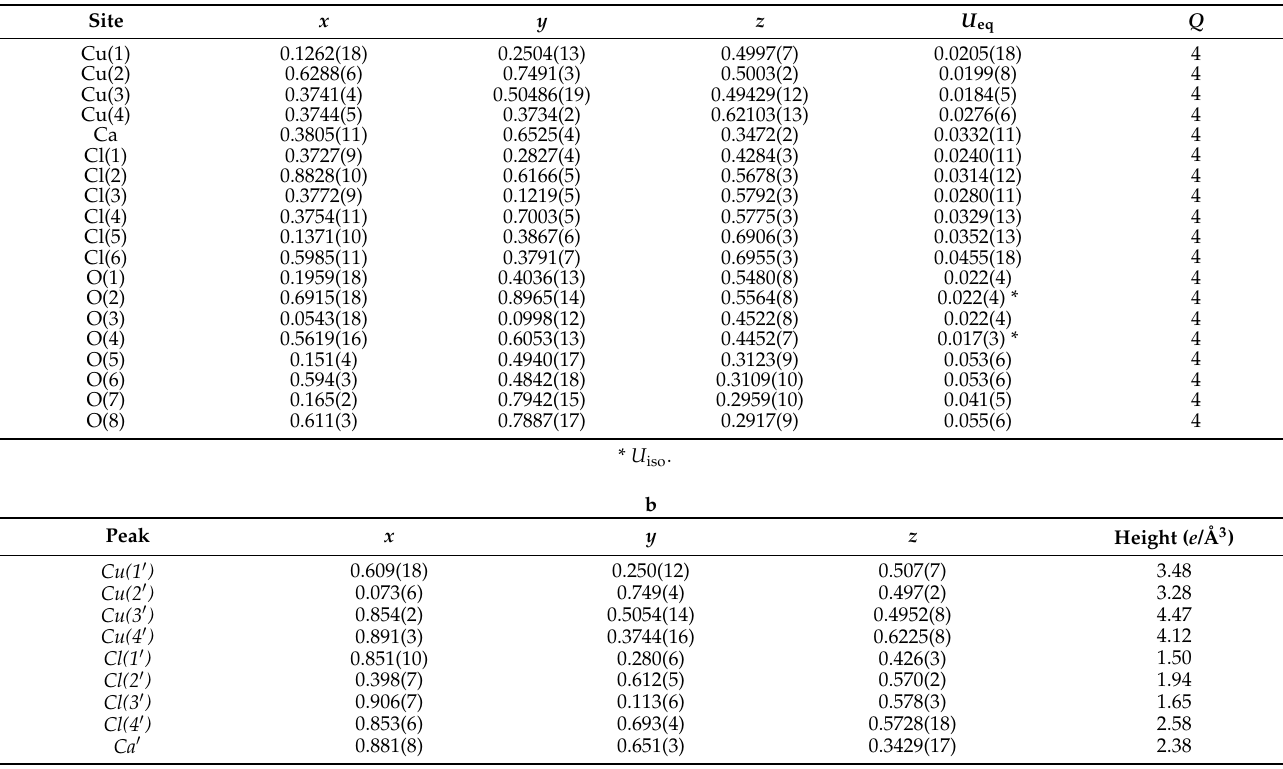
Table 5. ( a ) Coordinates, equivalent displacement parameters ( U eq , in Å 2 ) of atoms and site multiplicities ( Q ) for dioskouriite-2 O ; ( b